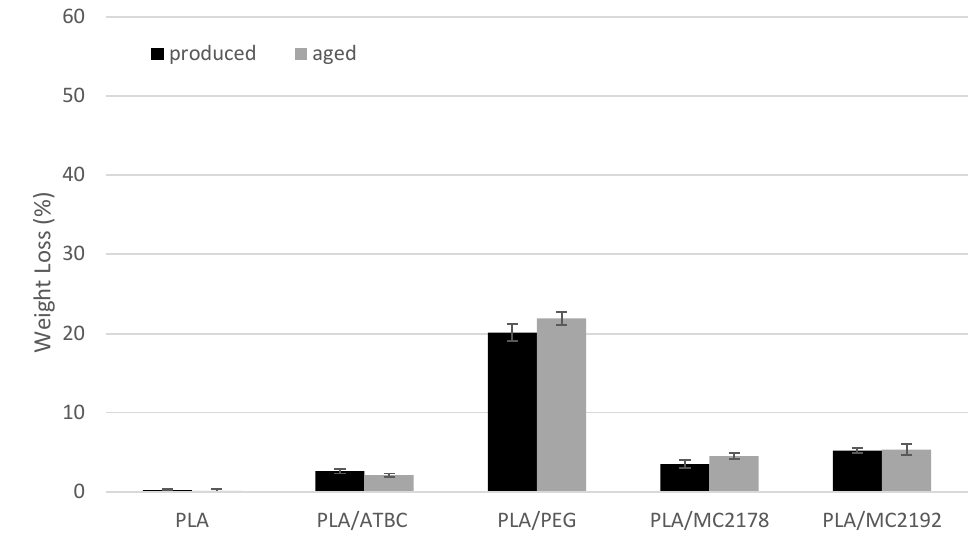
Figure 18. The weight loss of as-produced and aged PLA films after 14 days of composting.